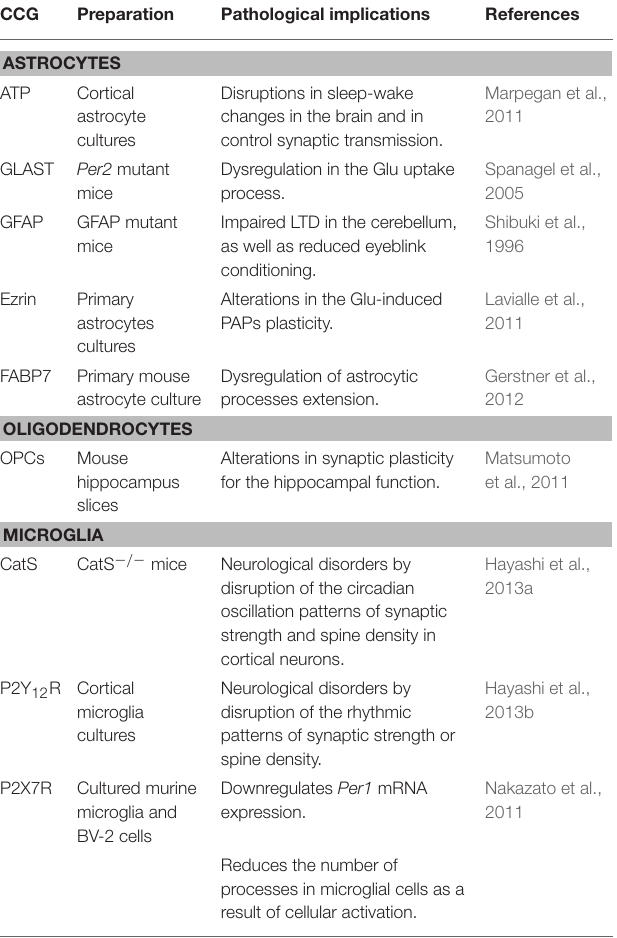
TABLE 1 | Clock-controlled genes (CCG) and their implications in brain